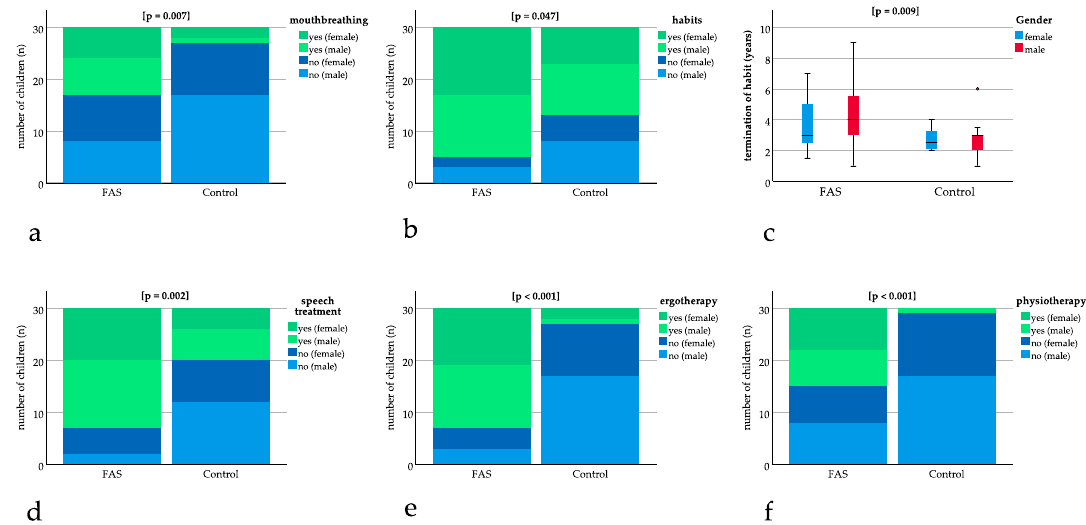
Figure 3. Bar charts with binary results (yes/no). Positive (“yes”) results are depicted in green (dark green female, light green male) and negative (“no”) results are depicted in blue (dark blue female, light blue male). The bar charts show significant differences in (a) mouthbreathing ( p = 0.007), (b) oral habits ( p = 0.047), (d) speech treatment ( p = 0.002), (e) ergotherapy ( p < 0.001), (f) physiotherapy ( p < 0.001). ( c ) Boxplot for significant difference in age at termination of sucking habits ( p = 0.009).